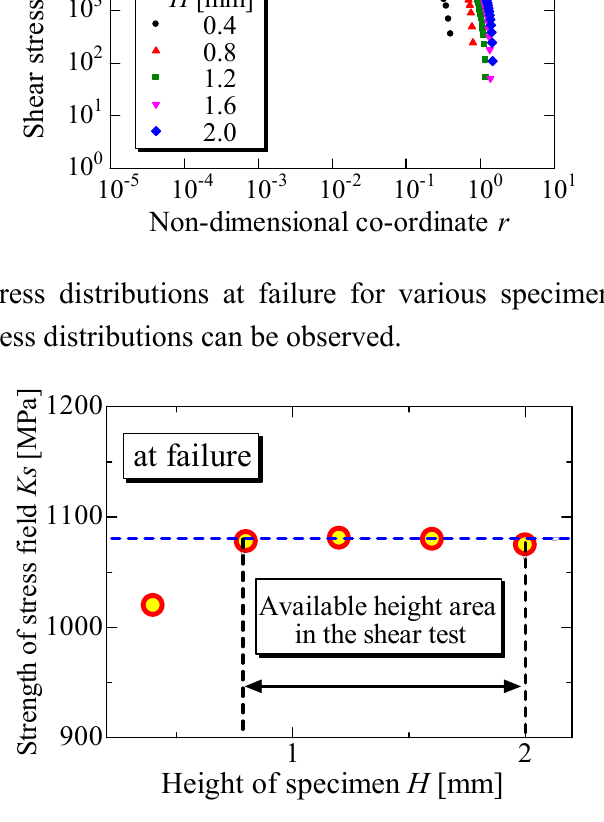
Figure 18. K s values at failure for various dimensions of specimen at the failure